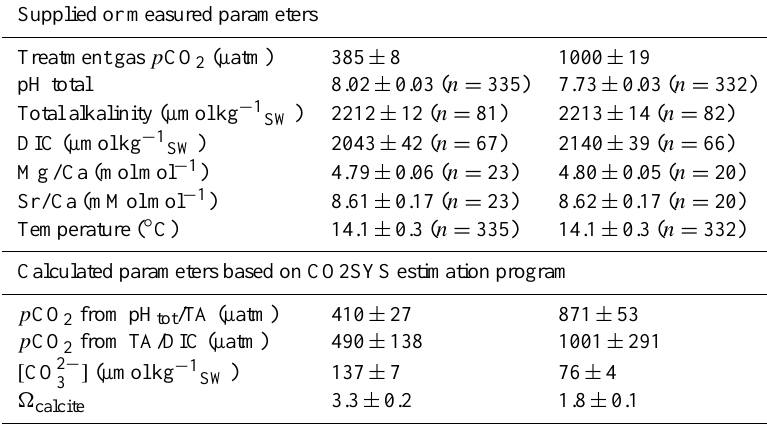
Table 2. Mean ( ± 1SD) culture conditions during the